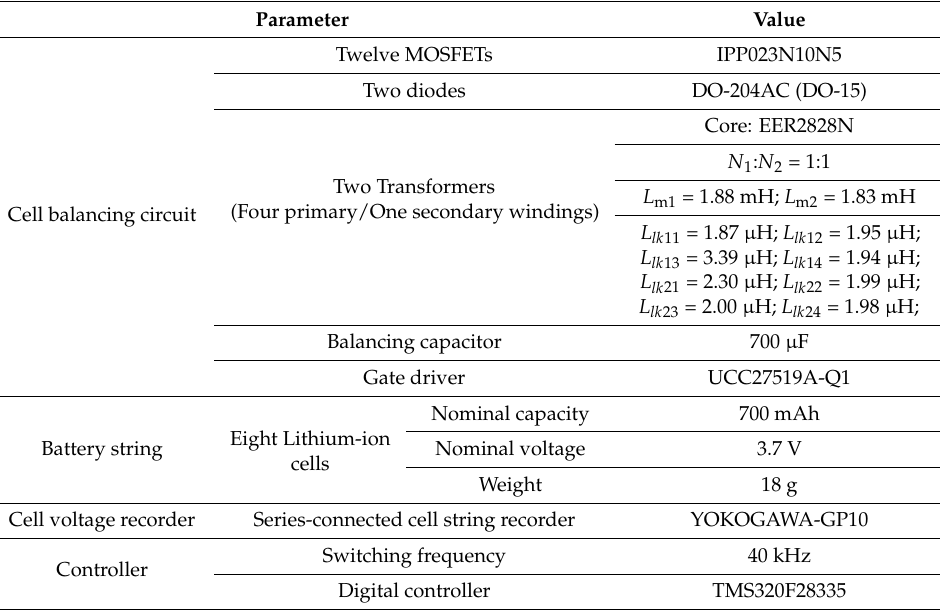
Table 1. The parameters of the proposed balancing